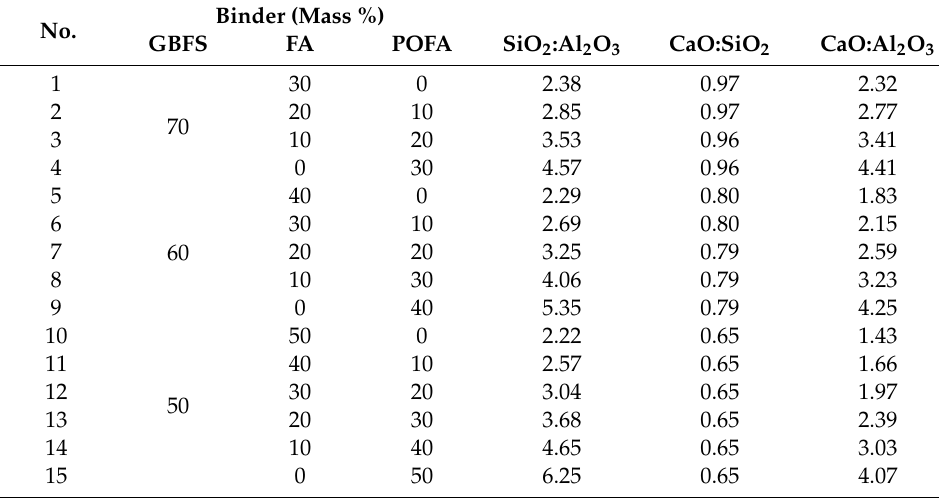
Table 4. Contents of constituents in high volume GBFS mix design.